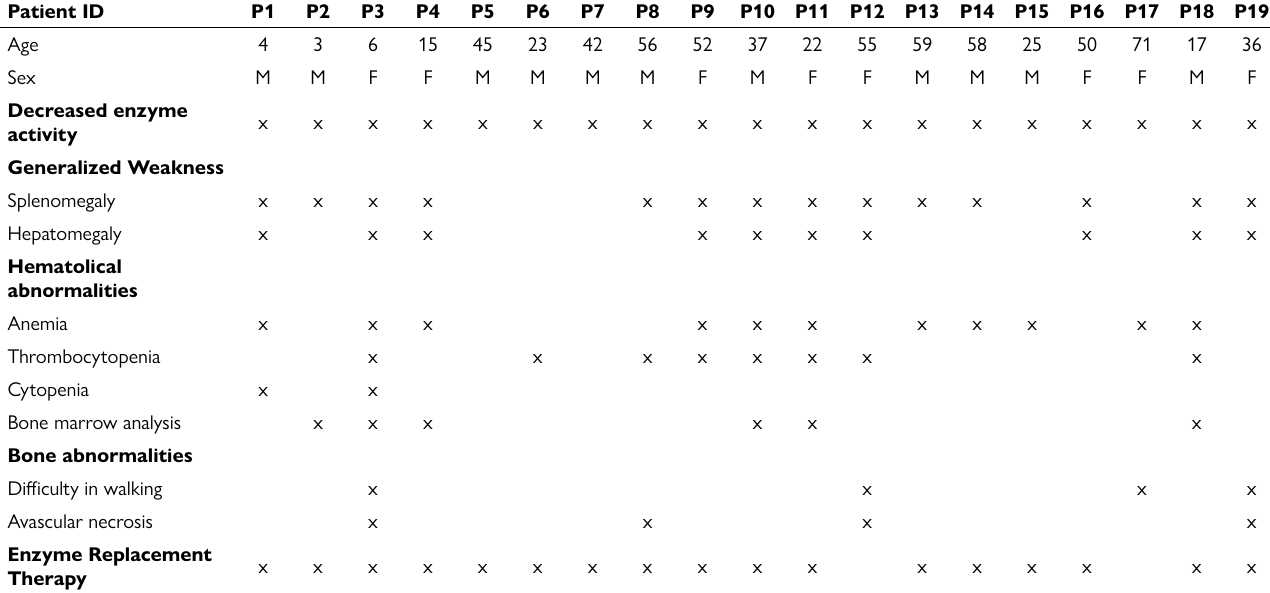
Table 1. Clinical details profile of patients from Southwest of Colombia with Gaucher disease. Patient ID